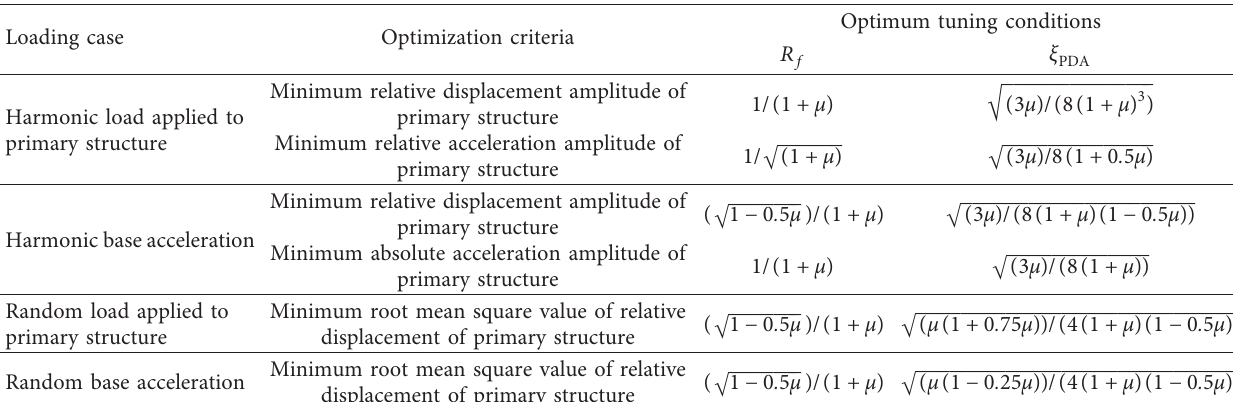
Minimum root mean square value of